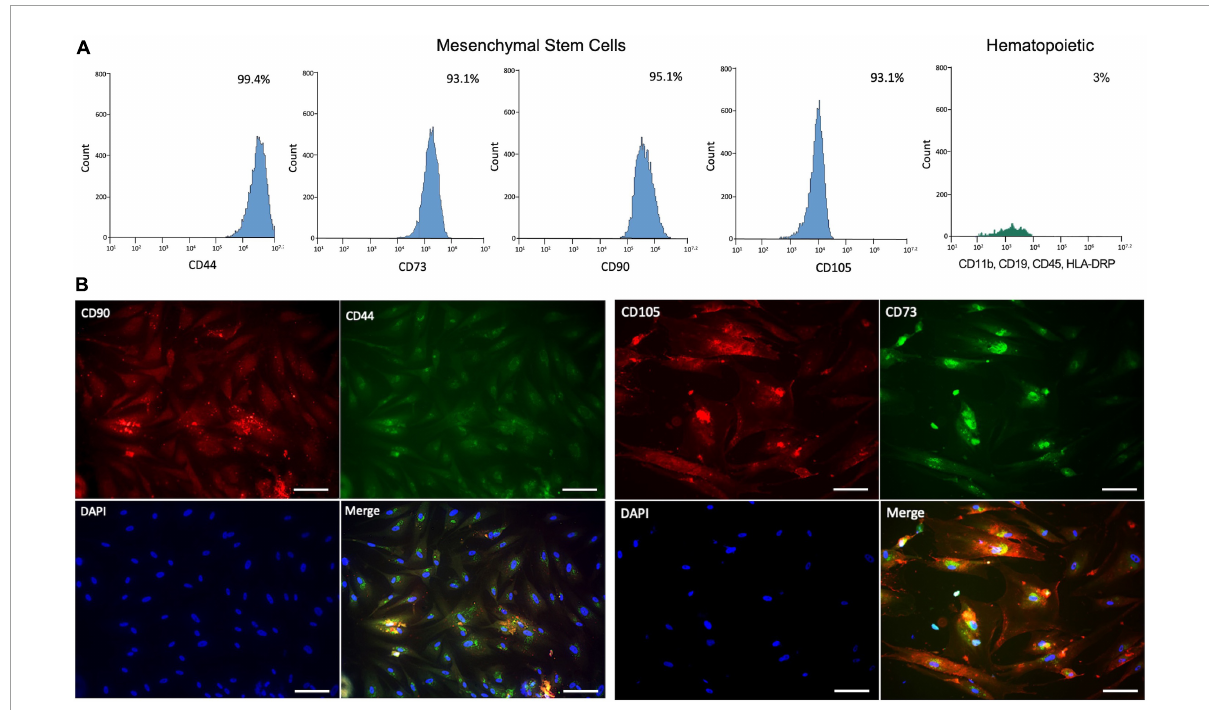
FIGURE1 Characterization of human mesenchymal stem cells (hMSCs). (A) Analysis of surface expression markers expressed in percent of hMSCs (CD44, CD73, CD90, and CD105) and hematopoietic (CD11b, CD19, CD45, and HLA-DRP) by flow cytometry. (B) Immunocytochemistry profile of hMSCs expression of surface marker expression in situ under fluorescence microscopy. Scale bar: 25 µ